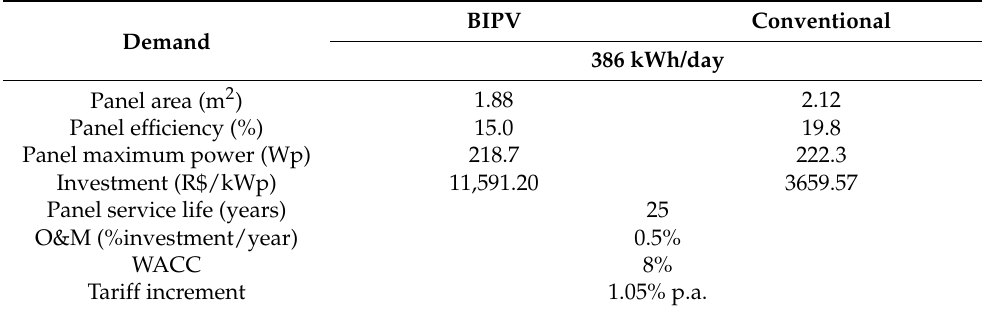
Table 5. Data used in the deterministic simulations of net present values (NPVs). BIPV Conventional Demand